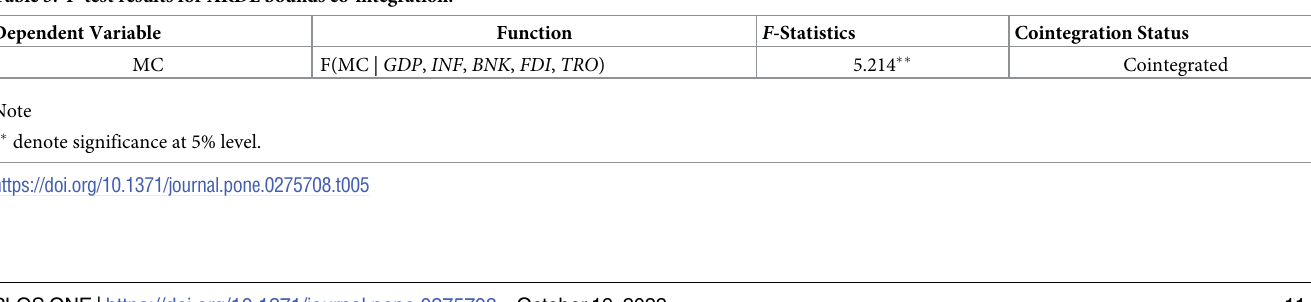
Table 5. F- test results for ARDL bounds